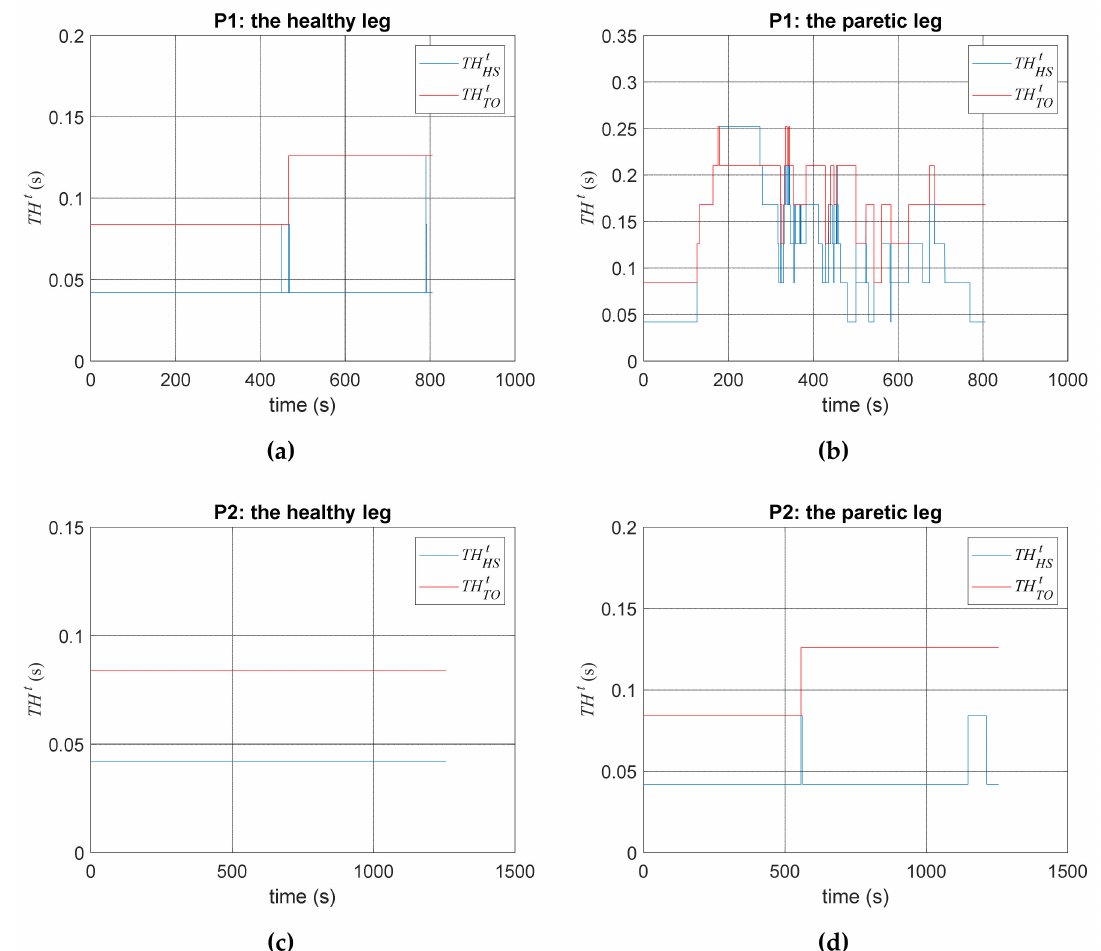
Figure 9. Parameter adjustment for gait detection. ( a ) On the healthy leg of P1; ( b ) on the paretic leg of P1; ( c ) on the healthy leg of P2; ( d ) on the paretic leg of